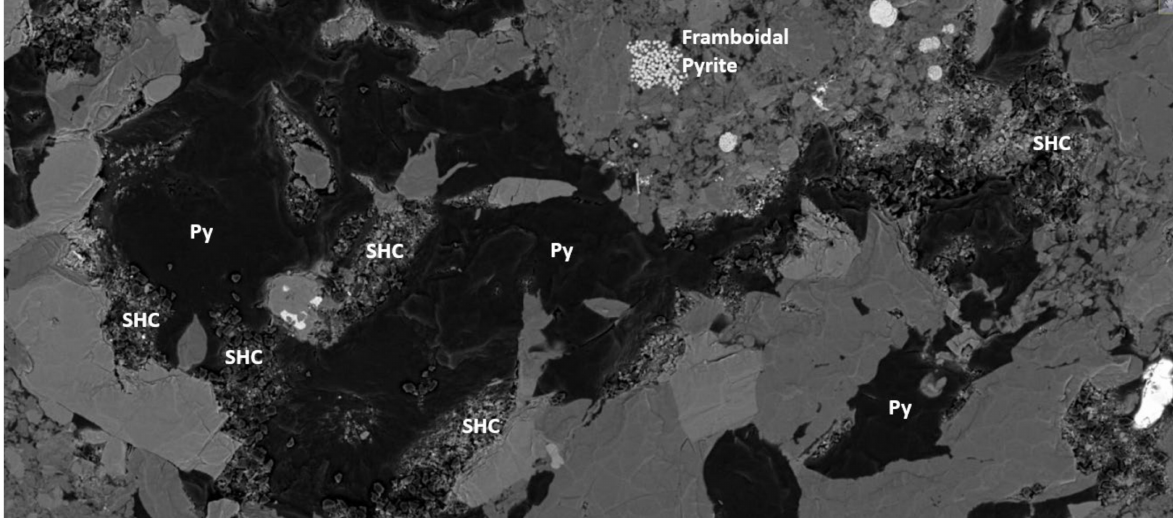
Figure 25. High-resolution large-scale mosaic of focused ion beam (FIB) BE SEM images [136] of non-productive, non-porous Marcellus shale sample from the Buda #1 well drilled in Luzerne